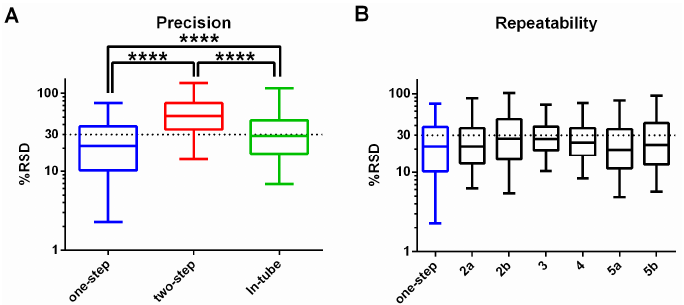
Figure 4. Precision and repeatability of the “One-step in-plate” method: The relative standard deviation (RSD) for each metabolite was determined for: ( A ) each of the extraction methods within a single experiment ( n = 3–4); and ( B ) the “one-step in-plate” method performed on seven independent occasions (Note: experiments 2a and 2b were analysed in a single LC-MS batch, as were 5a and 5b). Box plots represent the median ± interquartile range, and whiskers show the 5th and 95th percentile ( n = 3–4). **** p ≤ 0.0001, using one-way ANOVA with Tukey’s multiple comparison